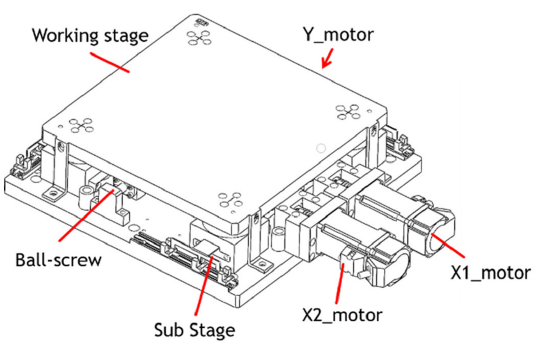
Figure 4. Coplanar XXY stage [13].